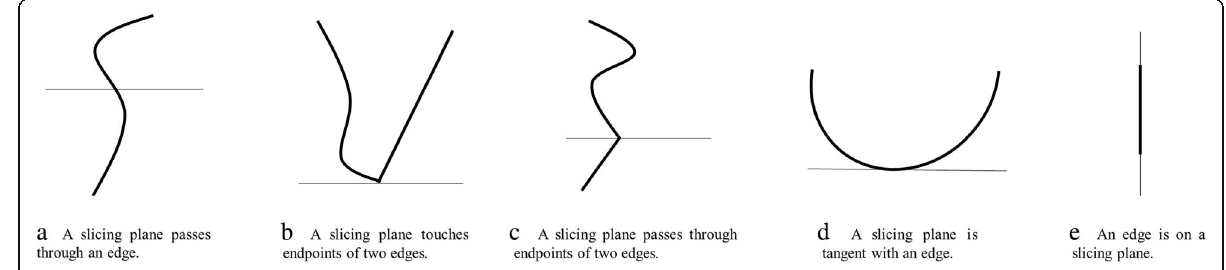
Fig. 3 Intersection results depend on directions of edges and slicing